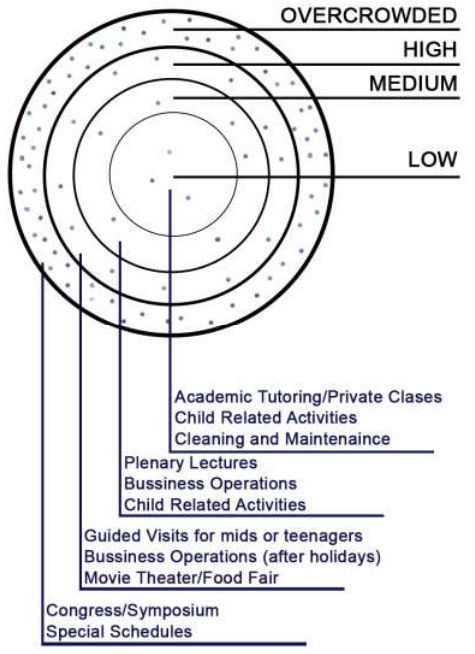
Figure 2. Relation between occupancy and activities.